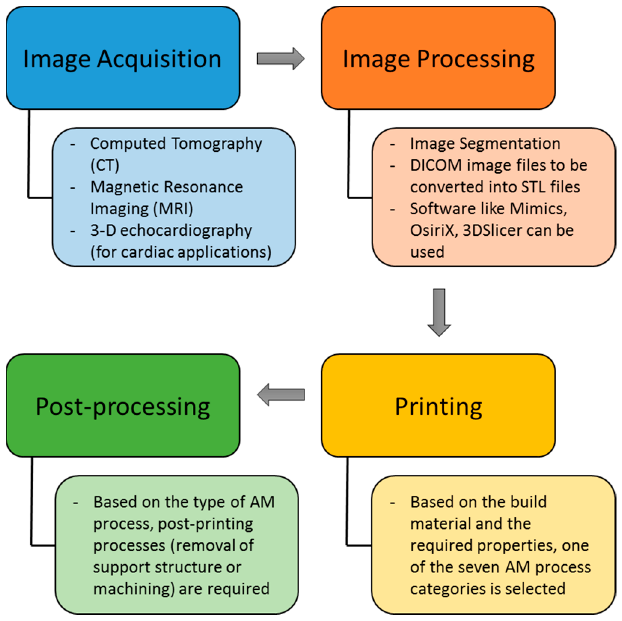
Figure 2. Steps involved in the fabrication of 3D models using Additive Manufacturing (AM) technologies.